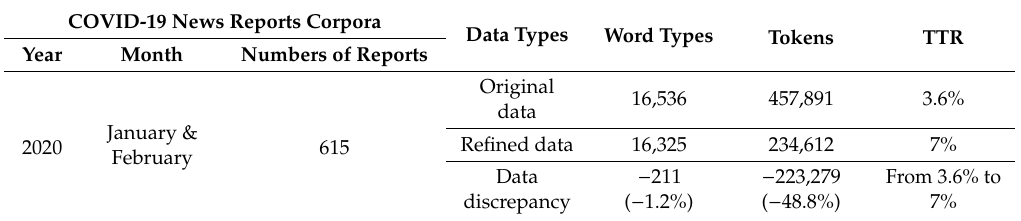
Table 8. A comparison of original and refined data of the “wordlist”.